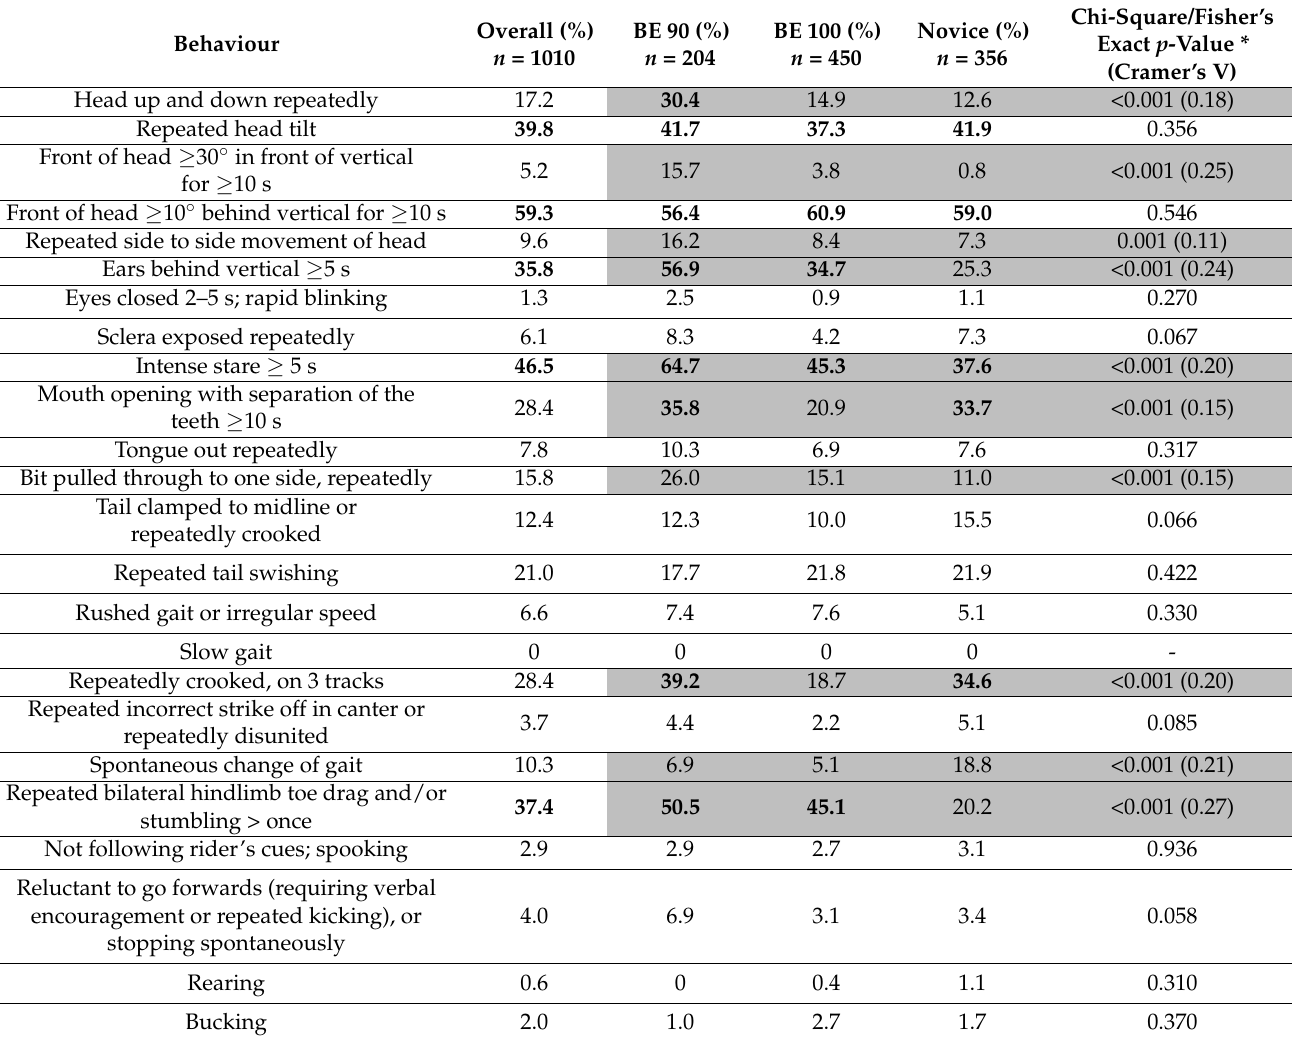
Table 4. The frequency of occurrence, expressed as a percentage of competition starts, of the 24 be- haviours of the Ridden Horse Pain Ethogram at British Eventing (BE) 90, 100 and Novice competitions. Behaviours observed in more than 30% of competition starts are highlighted in bold. Significant differences among competition levels are highlighted in grey.